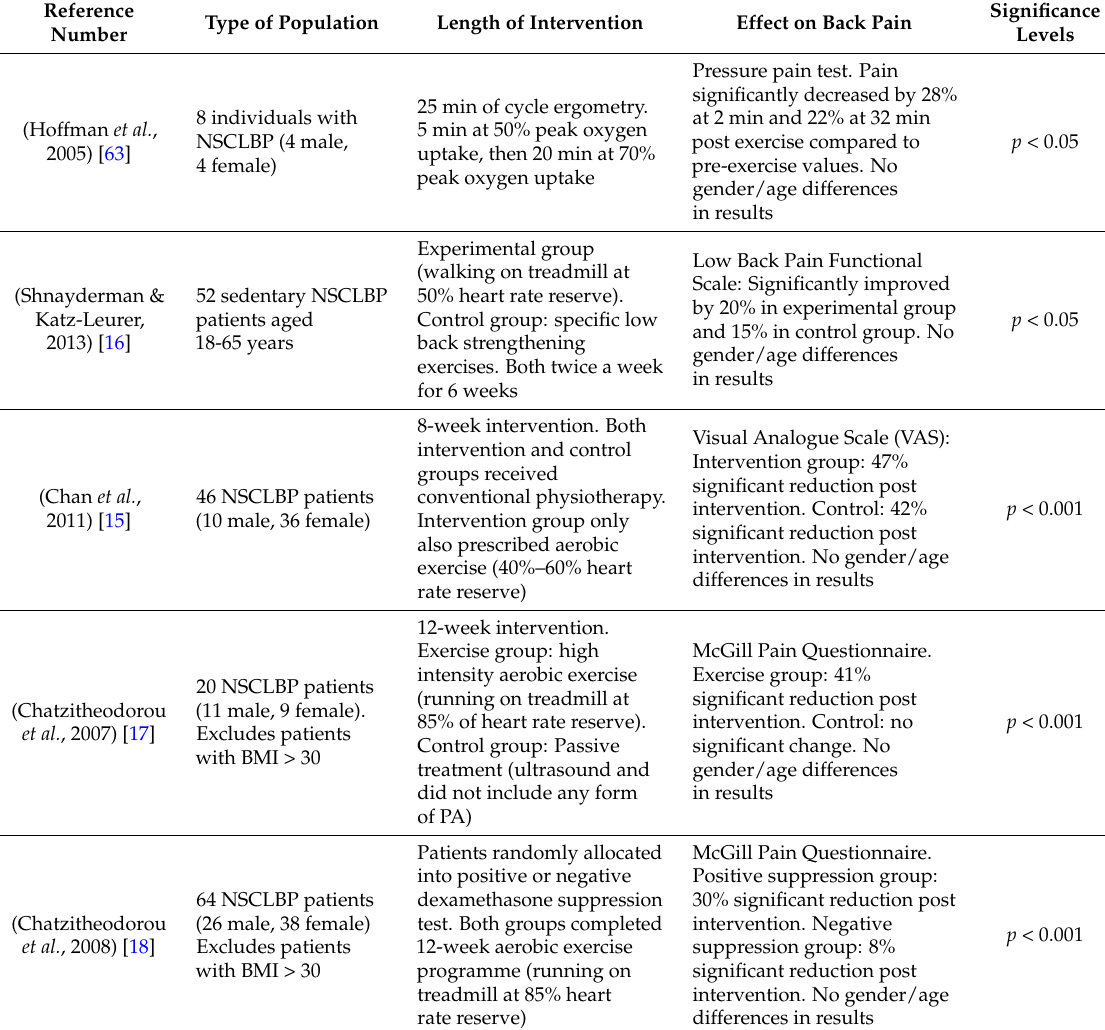
Table 1. Aerobic exercise intervention programmes for NSCLBP